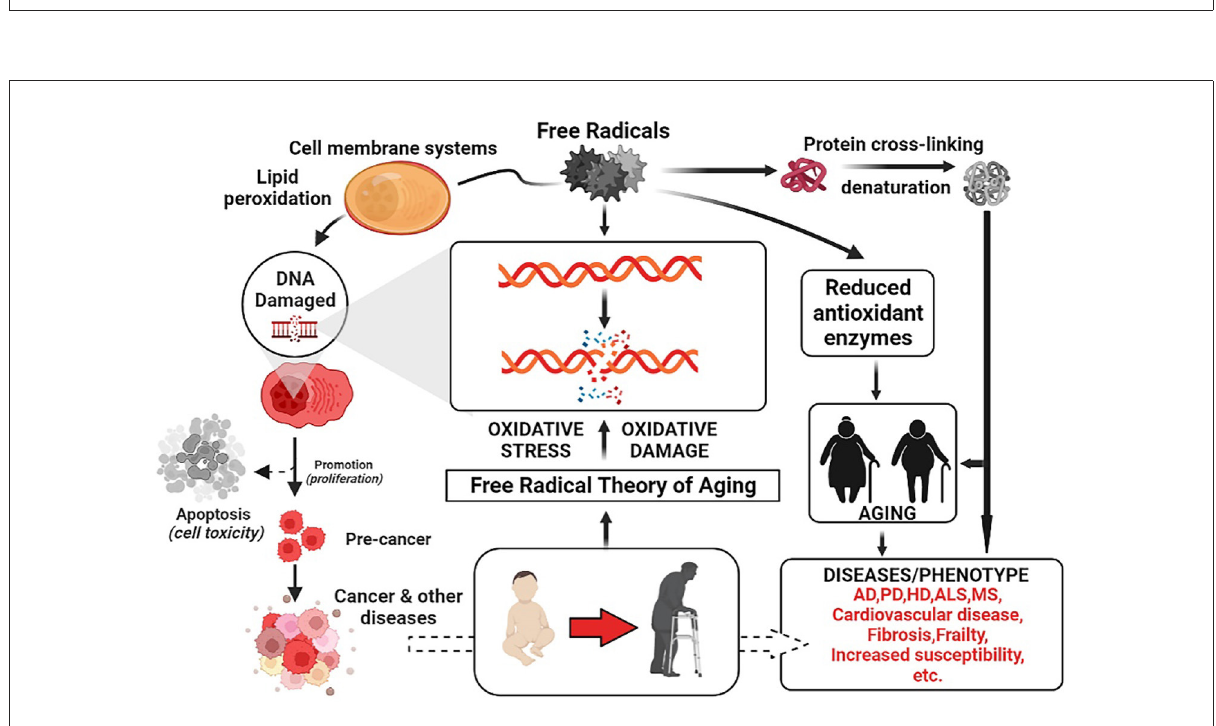
FIGURE10 Mechanisms of the free radical doctrine of aging (The figure was created employing online software named BioRender.com).